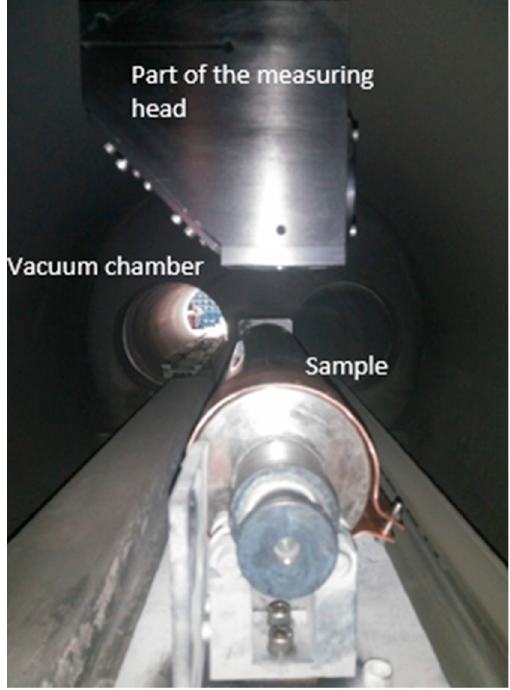
Figure 10. Copper ring sample in the vacuum chamber before coating.